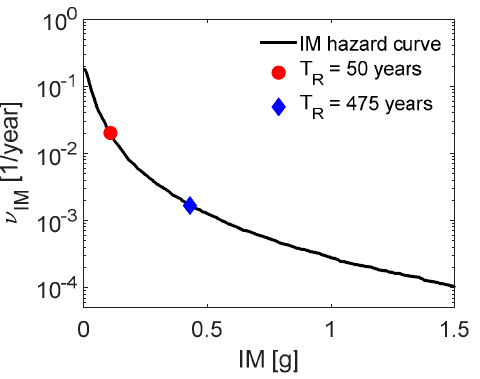
Figure 15. Intensity measure (IM) hazard curve for S a (T*) at T* = 0.75 s and reference IM levels.